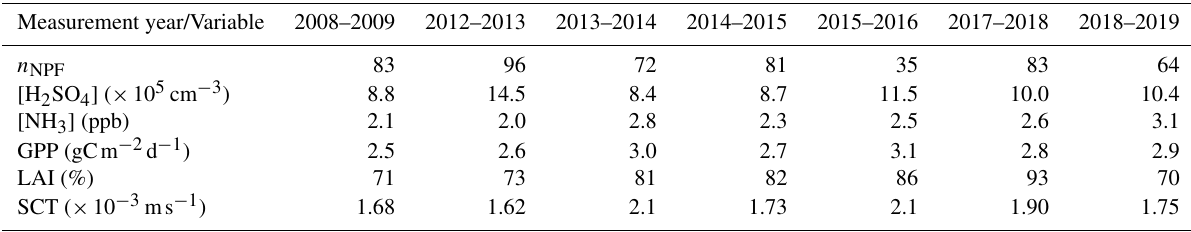
Table 1. Number of NPF event days ( n NPF ), annual median gas-phase H 2 SO 4 concentration and NH 3 mixing ratio, gross primary production (GPP) of vegetation, leaf area index (LAI), and stomatal conductance (SCT) for the 7 measurement years. The measurement units are indicated in